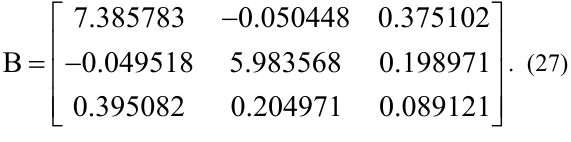
Fig. 4. Quadratic regression model for fitting on-site recorded data for (a) plant 1 and (b) plant 2.